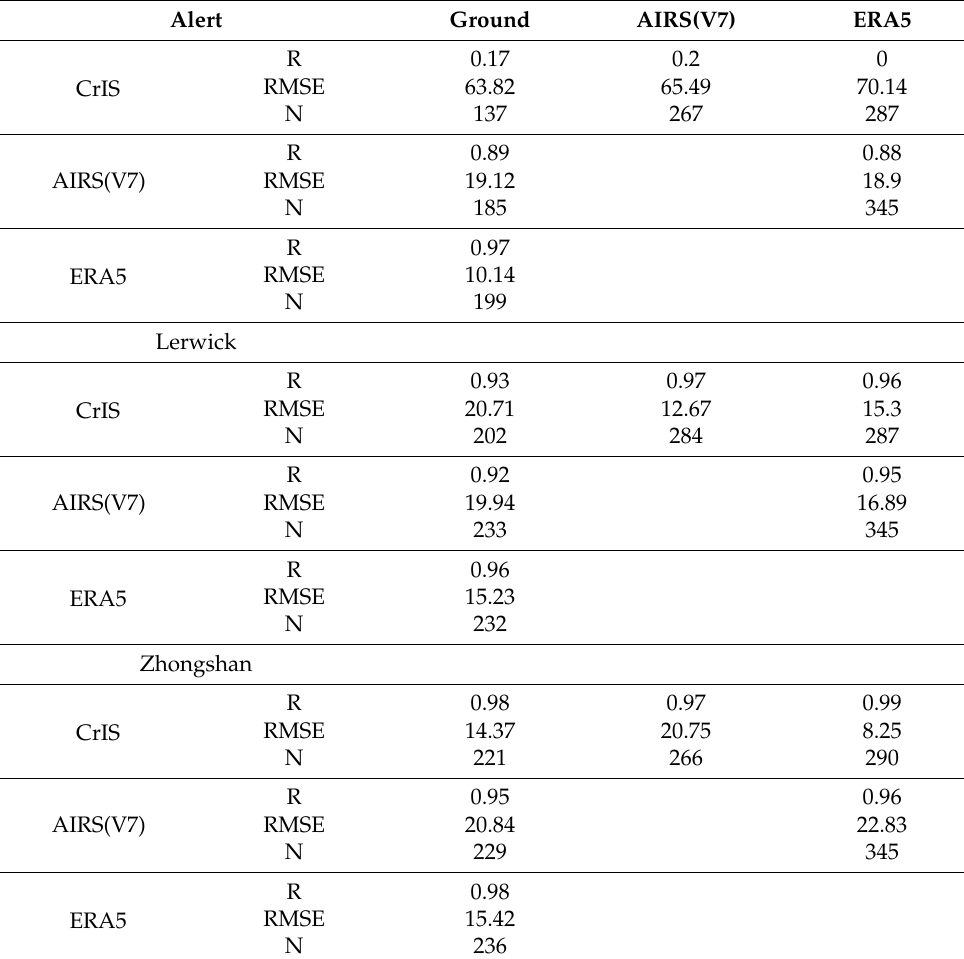
Table 2. Statistical metrics of total column ozone at Alert, Lerwick and Zhongshan